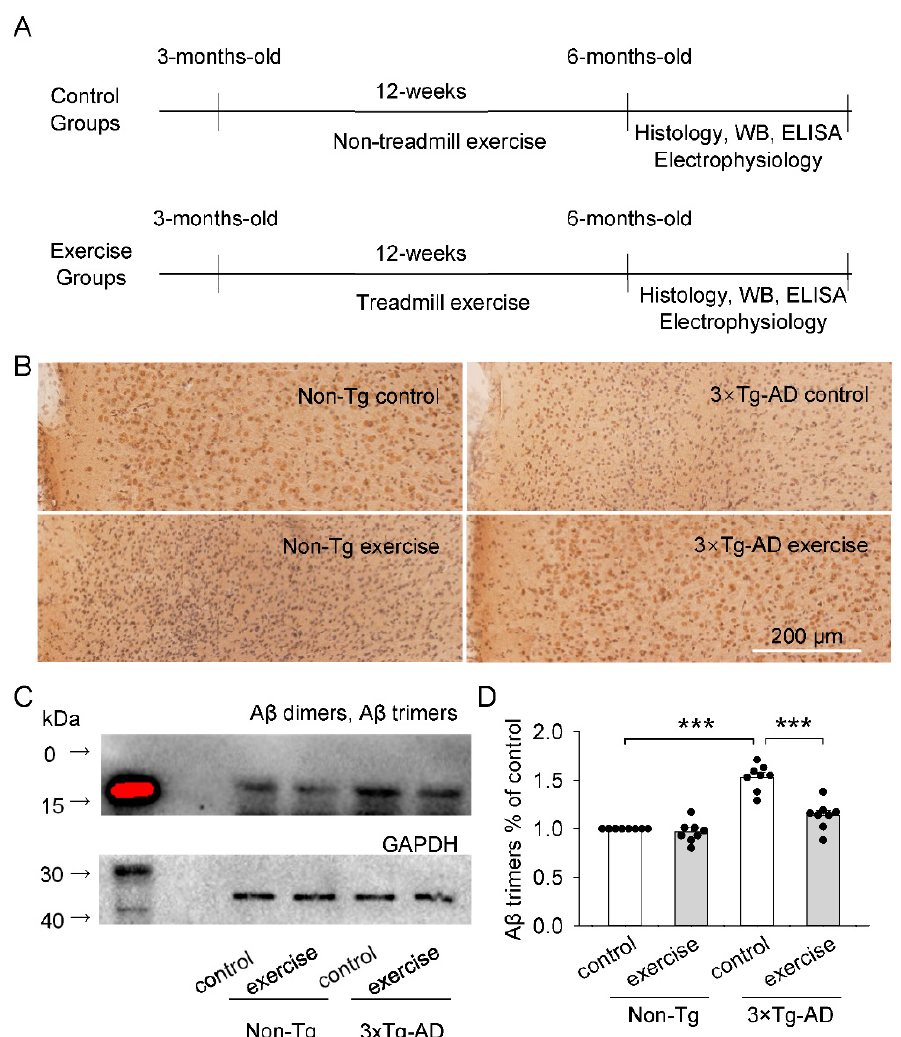
Figure 1. Treadmill exercise alleviated the A β pathology of the prefrontal cortex in 3 × Tg-AD mice. ( A ) Timeline of treadmill exercise or non-exercise control, histological test, and electrophysiology. ( B ) Representative microphotographs of the prefrontal cortex sections from 6-month-old mice stained with an anti-A β specific antibody (6E10, n = 8/group). No A β plaques were found in the prefrontal cortex sections. ( C ) Representative western blots for A β dimers, A β trimers and GAPDH of prefrontal cortex homogenates were prepared from these four groups of mice. Red in ( C ) represents western Blot image overexposure. The A β protein content was low, so the marker protein image showed overexposure. ( D ) Summarized data showed that A β trimers (*** p < 0.001, n = 8) in the prefrontal cortex were significantly increased in the 3 × Tg-AD mice compared to the non-Tg control group, and this increase was blocked by treadmill exercise pretreatment (*** p < 0.001, n = 8). See Supplementary Figure S1 for uncropped blots.